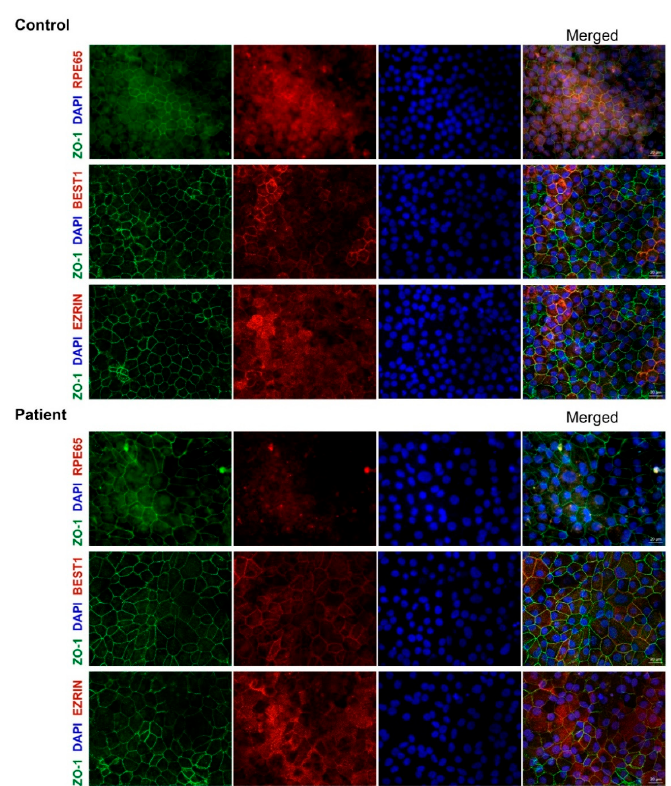
Figure 4. Immunocytochemical analysis of control and patient-derived RPE cells. P3 RPE cells were analyzed by ICC using several markers. In all case ZO-1 (green) stains the tight-junctions and DAPI (blue) stains the nuclei. In red, different RPE markers were assessed: RPE65 (first row), BEST1 (second row) and EZRIN (third row). Each channel is depicted individually and the merged is provided in the last column. Scale bar represents 20 µ m.